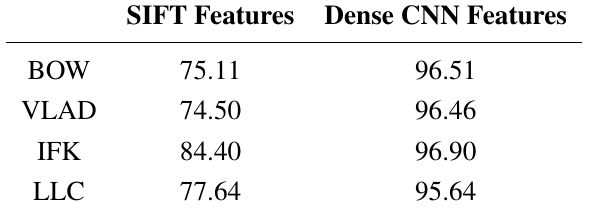
Table 6. Performance Comparison between SIFT Features and Dense CNN Features on the UCM